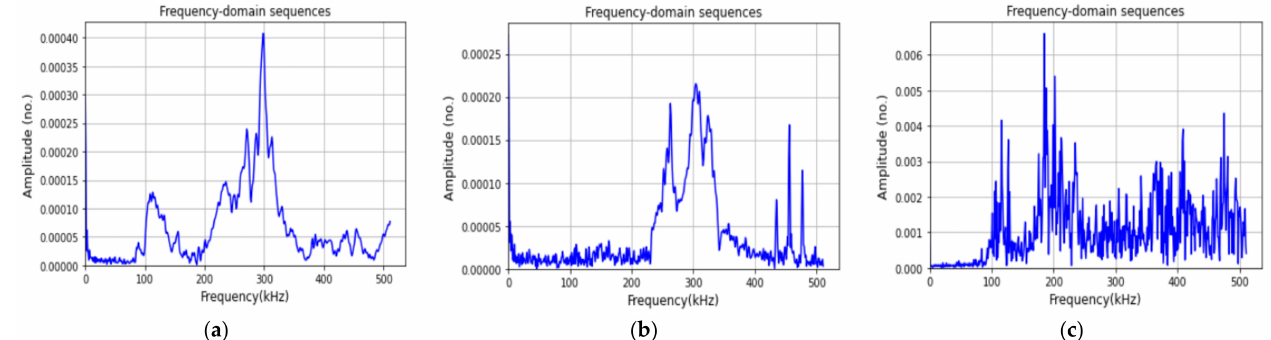
Figure 8. Several typical frequency-domain sequences determined by FFT: ( a ) fiber breakage, ( b ) matrix cracking, ( c )